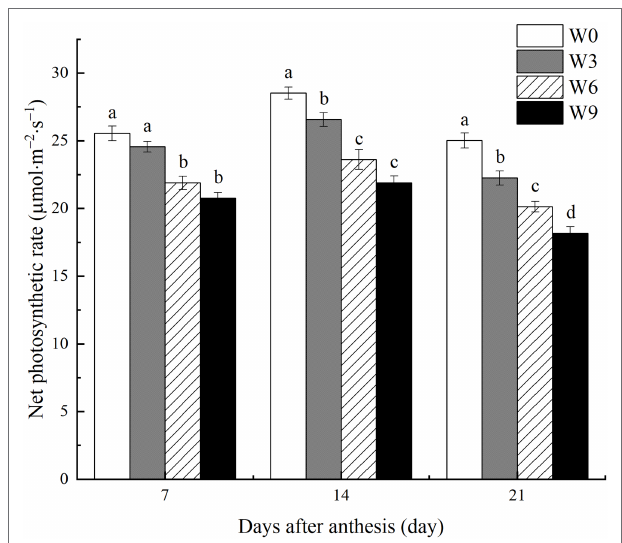
FIGURE 3 | Net photosynthetic rate of flag leaves under varying waterlogging durations. Data were collected at 7, 14, and 21 days after anthesis. W0 = control, W3 = 3 days of waterlogging, W6 = 6 days of waterlogging, W9 = 9 days of waterlogging. Vertical bars represent the mean of each treatment (six replicates across two years) ± SE (standard errors). Means carrying the same letter are not significantly different at the 5% level.